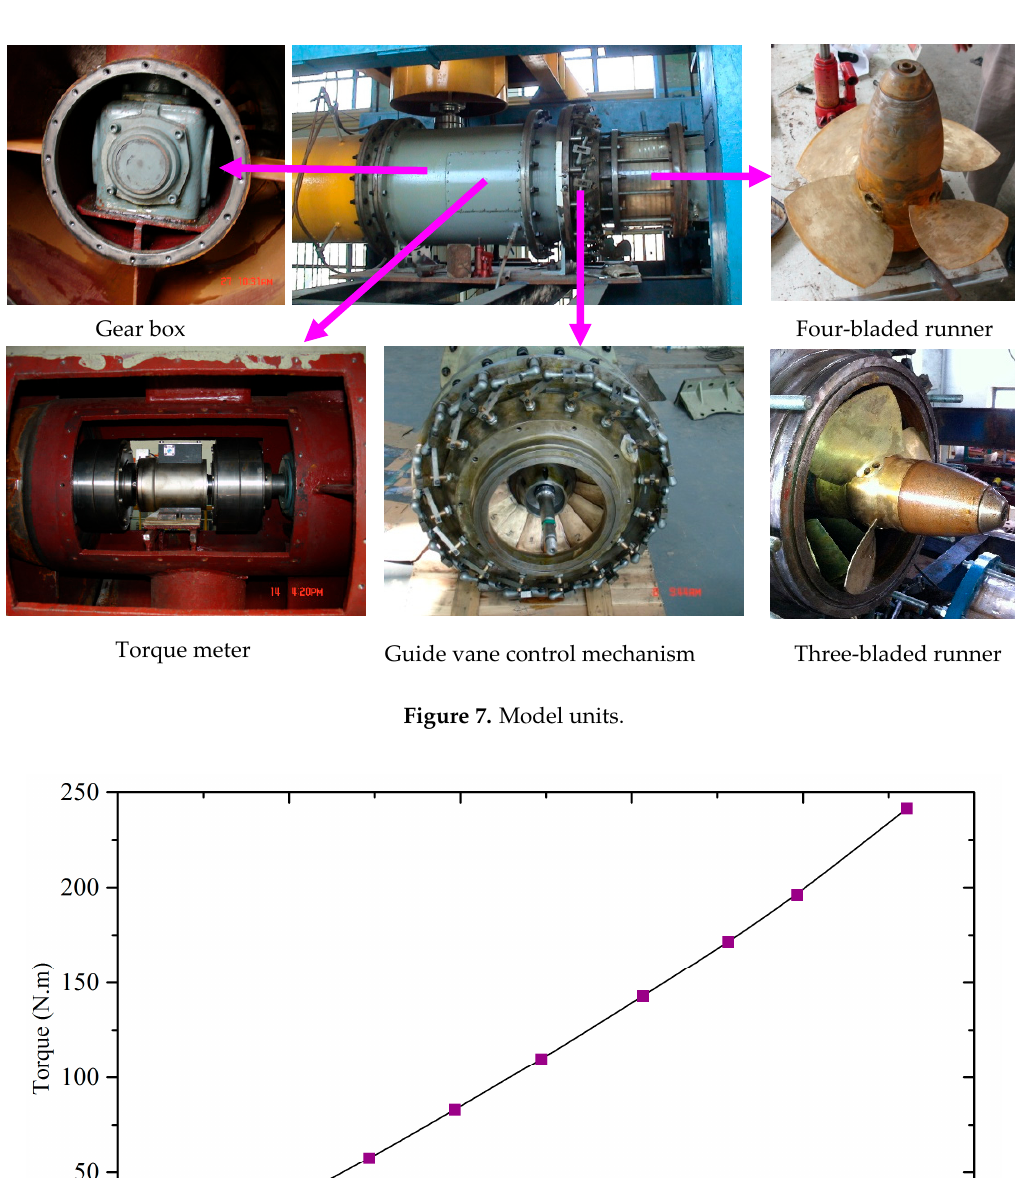
Figure 8. The experimental torque acting on the runner versus discharge Q for the optimal three-bladed runner.